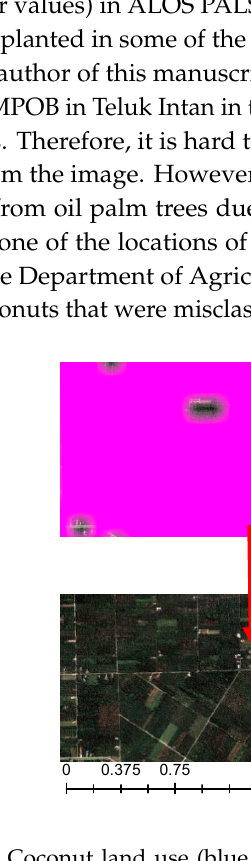
Figure 7. Misclassified coconut as oil palm: (a) Coconut land use (blue colored pixels) extracted from Land Use map overlaid on oil palm area classified in this study (pink); (b) Google Earth image showing coconuts.